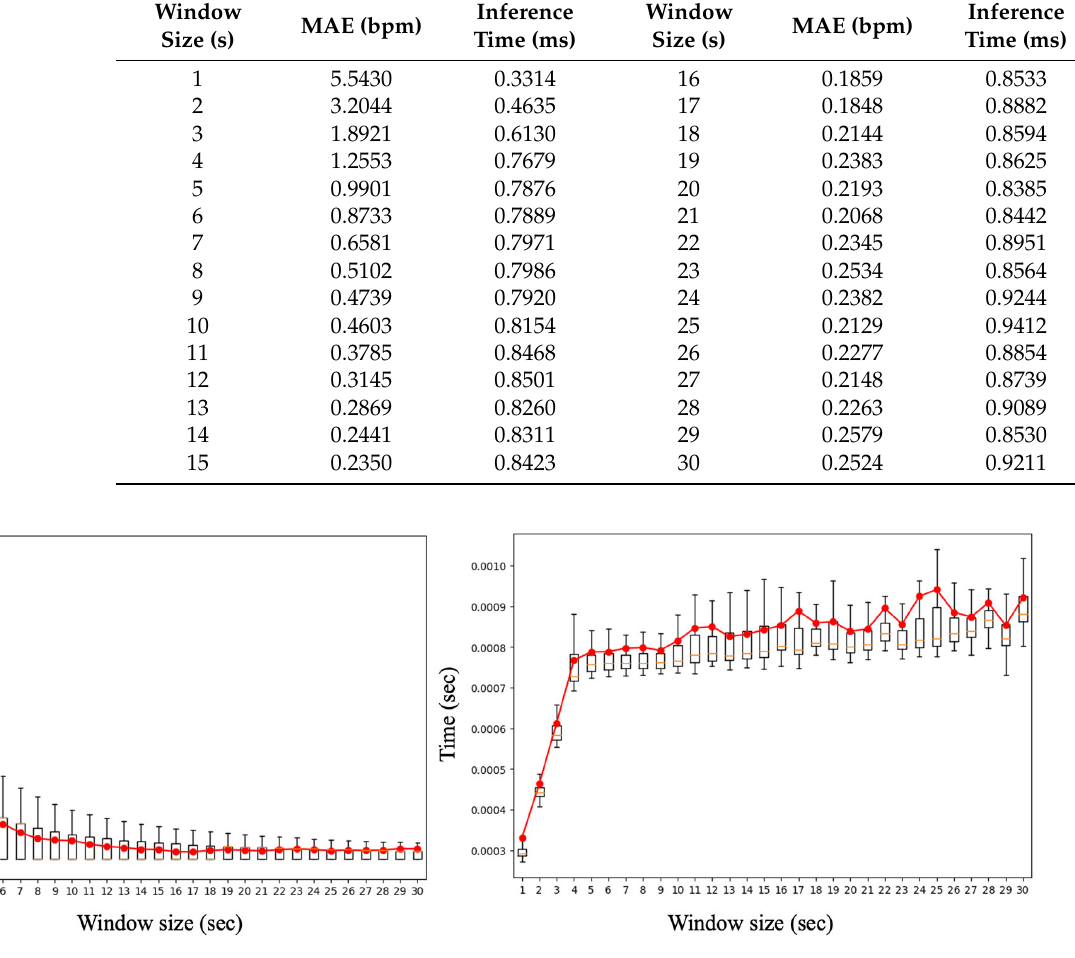
Figure 10. Comparison of respiration estimation accuracy and computational time according to window size change. Table 3. The changes in the accuracy and inference time according to window size.